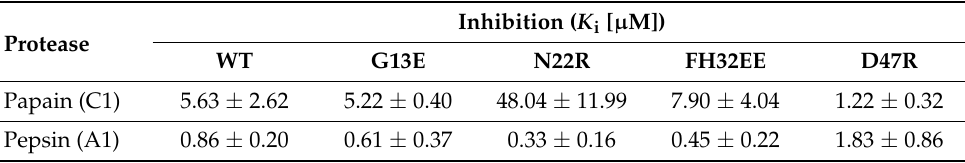
Table 3. Inhibition constants of papain and pepsin by CCP1 mutants. Equilibrium constants for the inhibition of papain and pepsin were determined according to Henderson [27]. Experiments were performed at 30 ◦ C. S.D. are given where appropriate; NI, no inhibition.